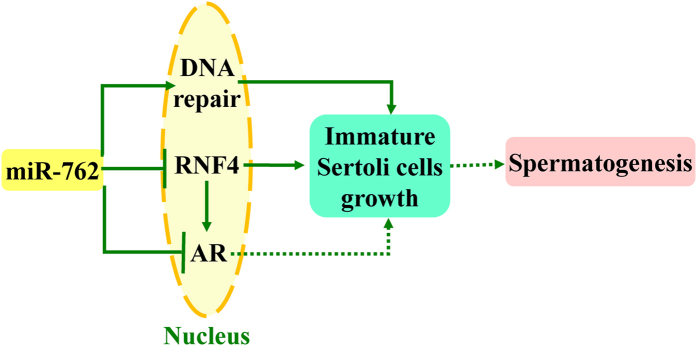
Model of the main findings of this study.miR-762 promotes immature Sertoli cells proliferation and inhibits apoptosis by inhibiting RNF4 and AR and by enhancing DNA damage repair capacity, and miR-762 is speculated to function in pig spermatogenesis.